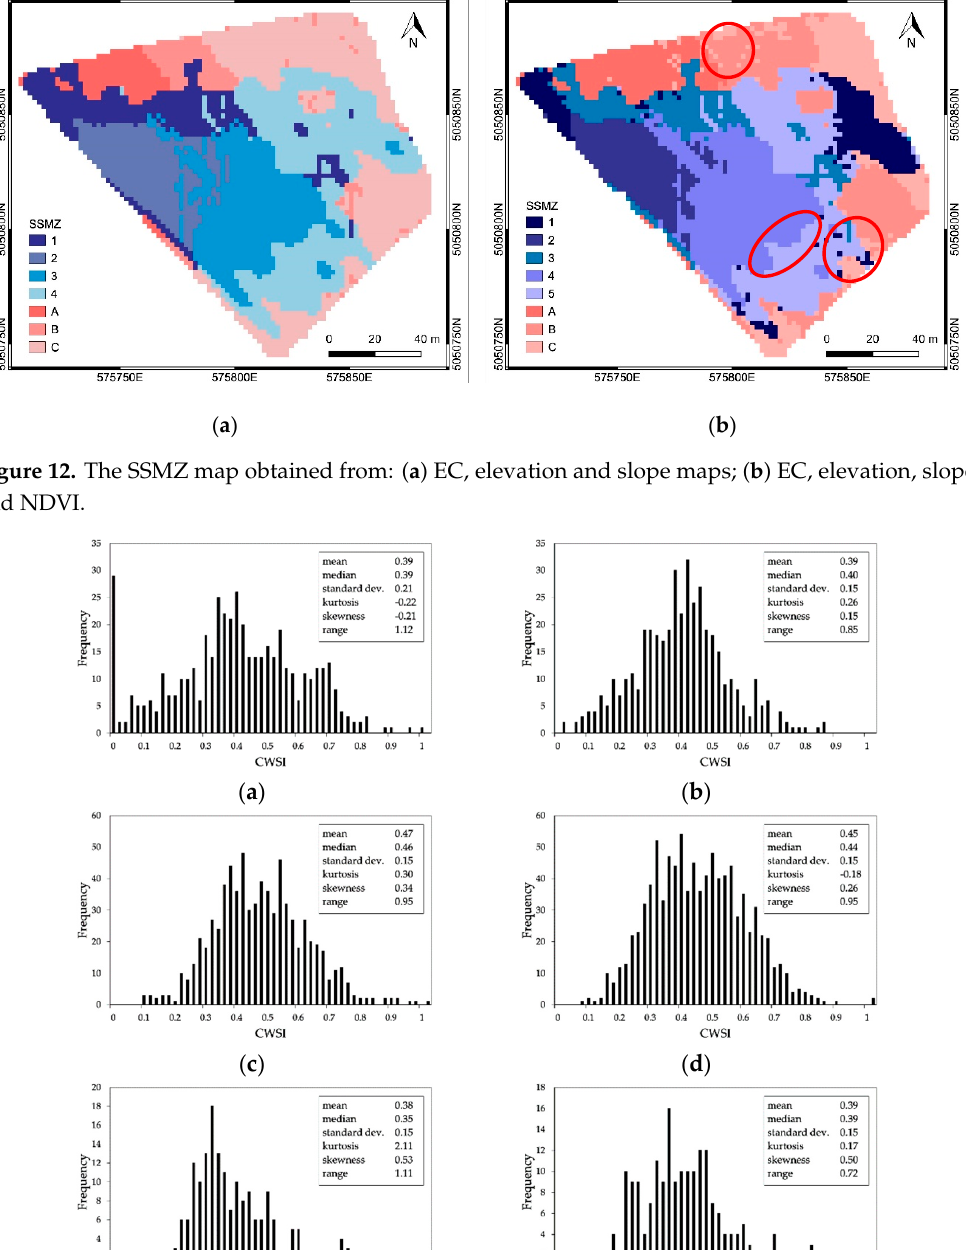
(Table 6), obtained from the EC, elevation, slope and NDVI maps: PC a1 represented mainly the physical-chemical soil properties (correlation coefficients with EC greater than 0.90), and partly the DTM (correlation coe ffi cient equal to − 0.48); PC a2 represented the topography (correlation coefficients with DTM and Slope equal to 0.72 and − 0.45, respectively); PC a3 represented both the topography (correlation coefficient with Slope equal to − 0.61) and the crop vigor (correlation coefficient with NDVI equal to 0.59) which are negatively correlated (see Table 2). For area ‘b’, CA was applied to the first two principal components PC b1 and PC b2 (Table 7), obtained from the elevation, slope and NDVI maps: PC b1 represented the topography (correlation coefficients with DTM and Slope equal to − 0.89 and 0.88, respectively); PC b2 represented the crop vigor (correlation coefficient with NDVI equal to 0.99). Within areas ‘a’ and ‘b’, respectively, five SSMZs (numbered from 1 to 5) were delineated from EC, elevation, slope and NDVI maps, and three SSMZs (numbered from A to C) were delineated considering only elevation, slope and NDVI maps. The resulting SSMZ map is shown in Figure 12b. The SSMZs 1–3, A and C corresponded to low CWSI values, while SSMZs 4, 5, and B mostly